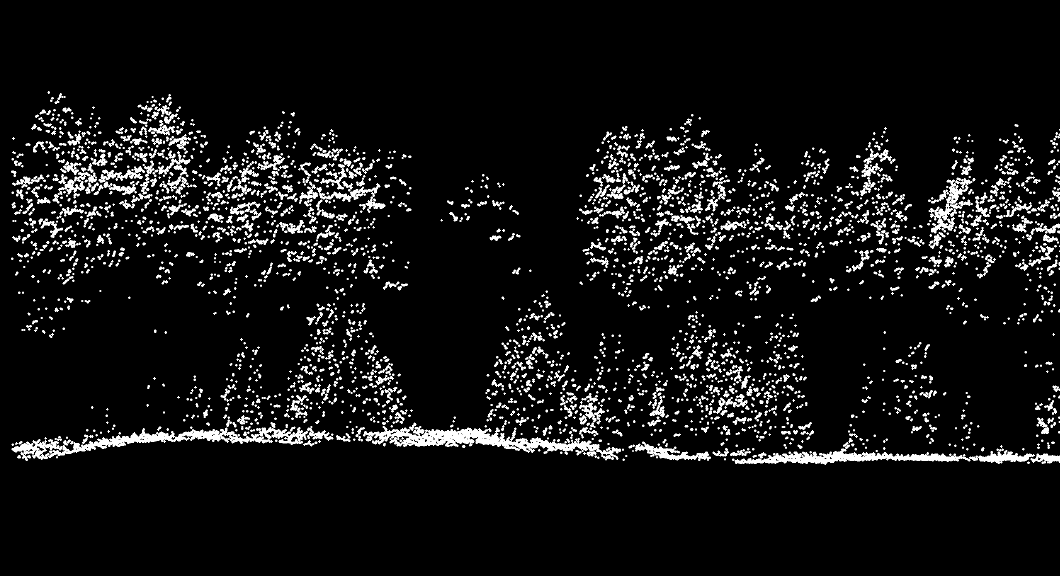
Figure 3. The image illustrates a transect of Optech Titan